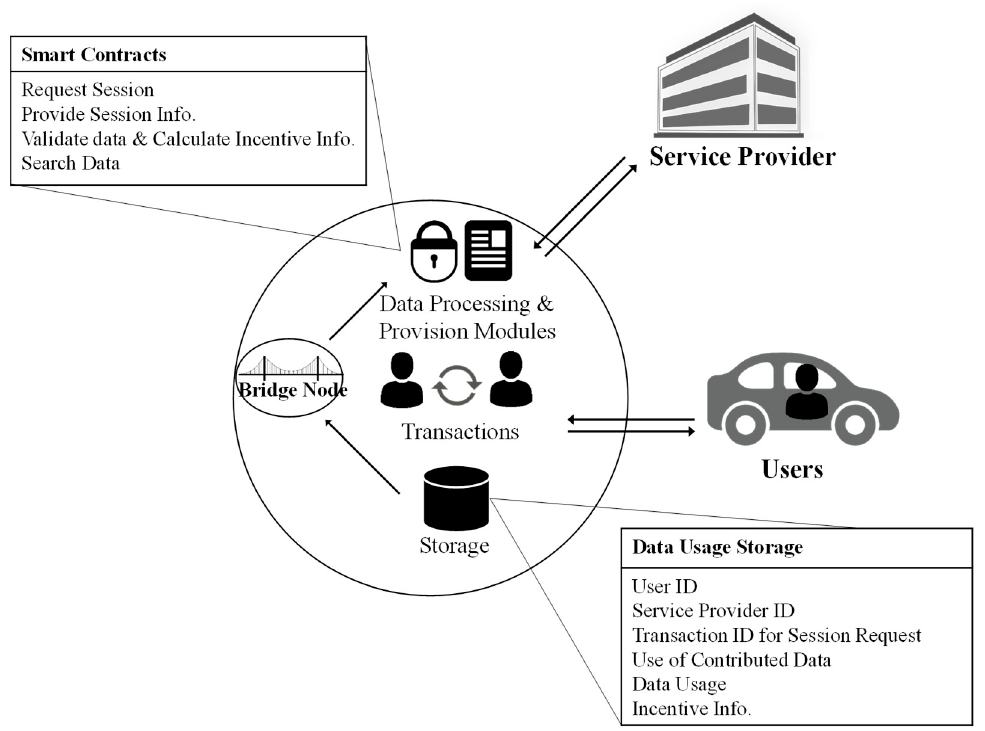
Figure 5. Structural diagram of a private blockchain.